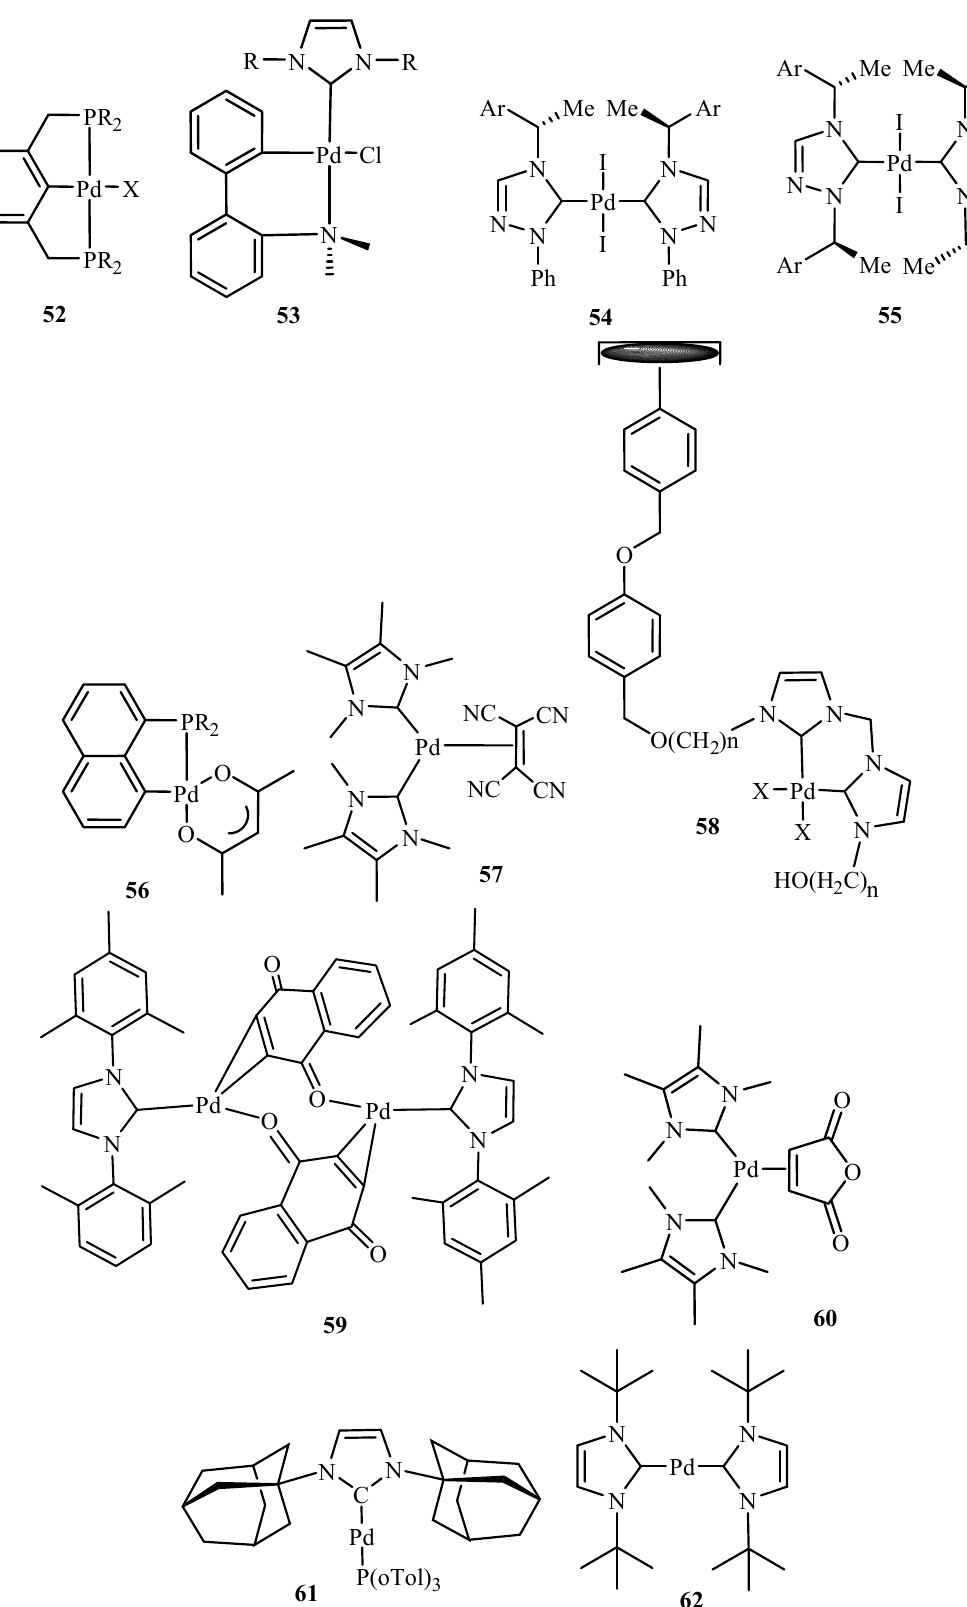
Figure 8. Palladium complexes with phosphorus and N-heterocyclic carbene ligands reviewed by Herrmann et al.